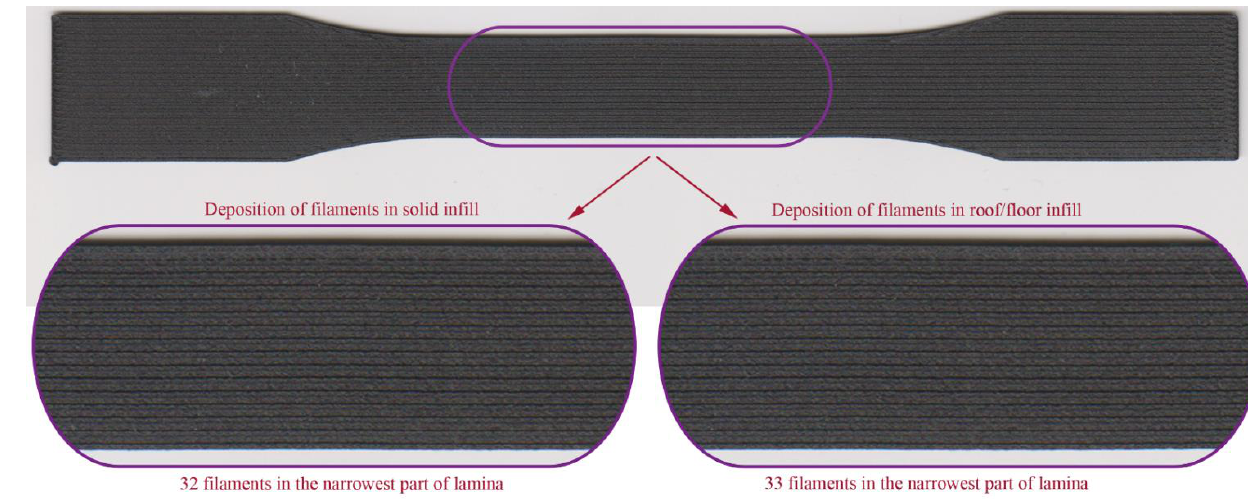
Figure 8 . Deposition of filaments in the narrowest part of lamina. Figure 8. Deposition of filaments in the narrowest part of lamina.